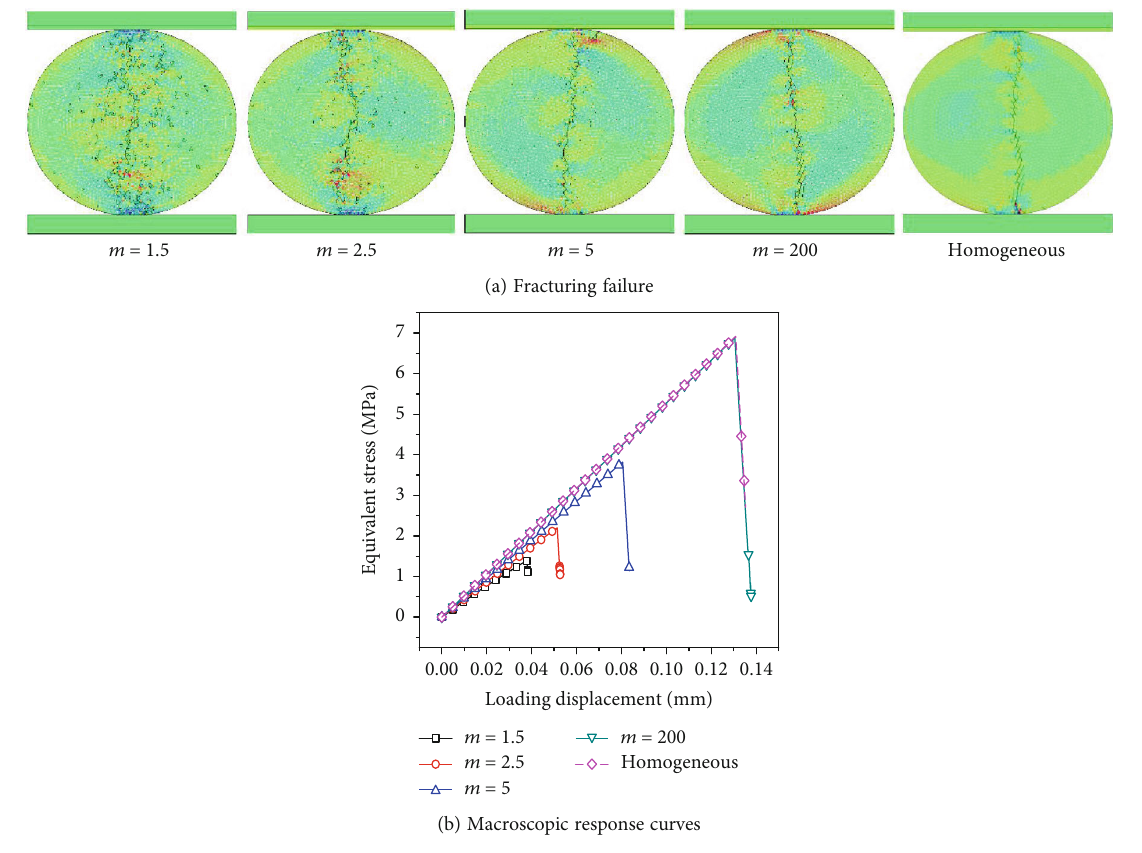
Figure 10: Simulation results of the disc with di ff erent heterogeneity index